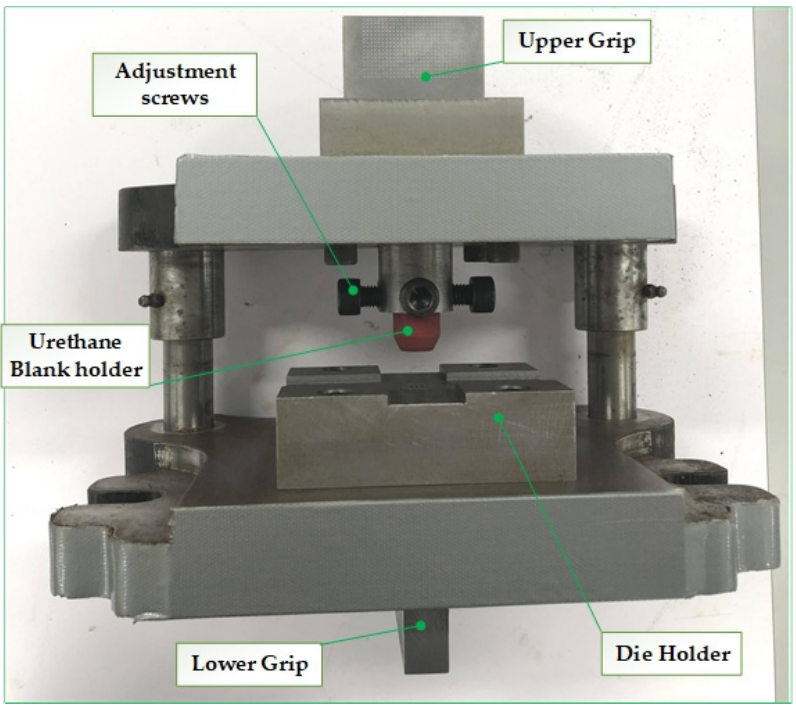
Figure 3. Experimental setup: Clinching die set.